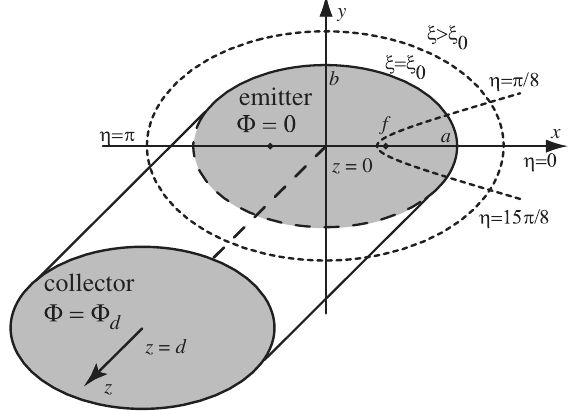
FIG. 1. A beam of elliptic cross section (semimajor axis a , semiminor axis b ) is shown in Cartesian and elliptic-cylindrical coordinates. The beam is emitted from an elliptic plate at (cid:1) (cid:7) 0 in the z (cid:7) 0 plane and collected by an elliptic plate at (cid:1) (cid:7) (cid:1) the z (cid:7) d plane. The beam fills the area enclosed by the surface (cid:17) (cid:7) (cid:17) . In any z plane, lines of constant (cid:17) are ellipses, and lines 0 of constant (cid:18) are